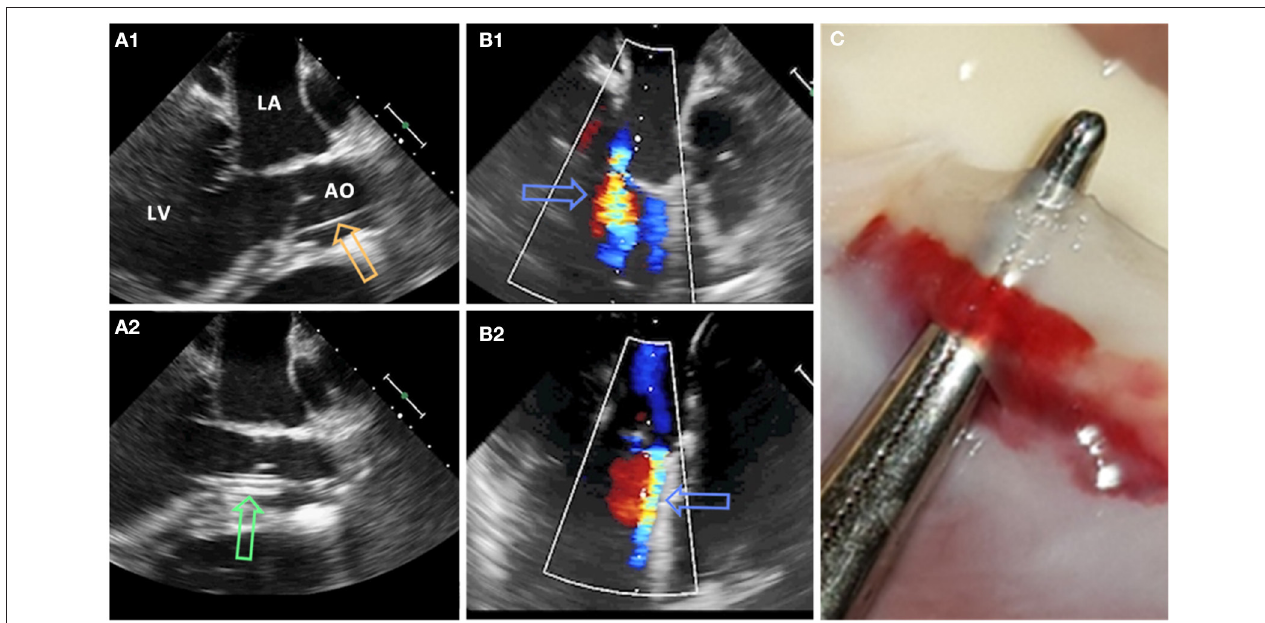
FIGURE 1 | Pierce and dilate technique used to create the model of mild eccentric aortic regurgitation/para valvular leakage (AO, aorta; LA, left atrium; LV, left ventricle). (A1) Coronary guide wire (orange arrow) is used to pierce the leaflet/annulus at the hinge point. (A2) Standard PTCA 5mm balloon (green arrow) is positioned across the defect and inflated. (B1,B2) Aortic regurgitant jet (blue arrows) originating from NCC and RCC region, respectively. (C) Defect of the aortic valve at the hinge point of the